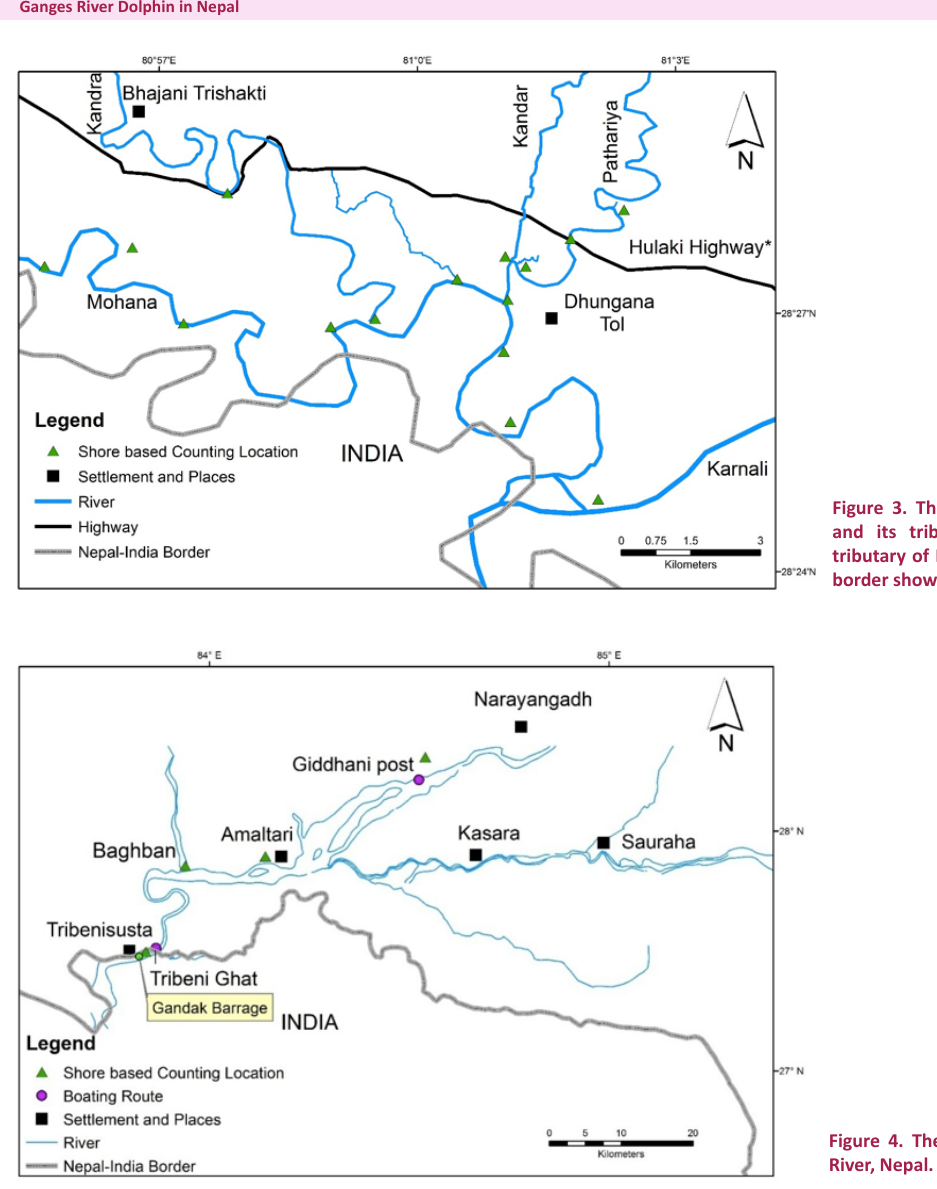
Figure 4. The surveyed areas in Narayani River,